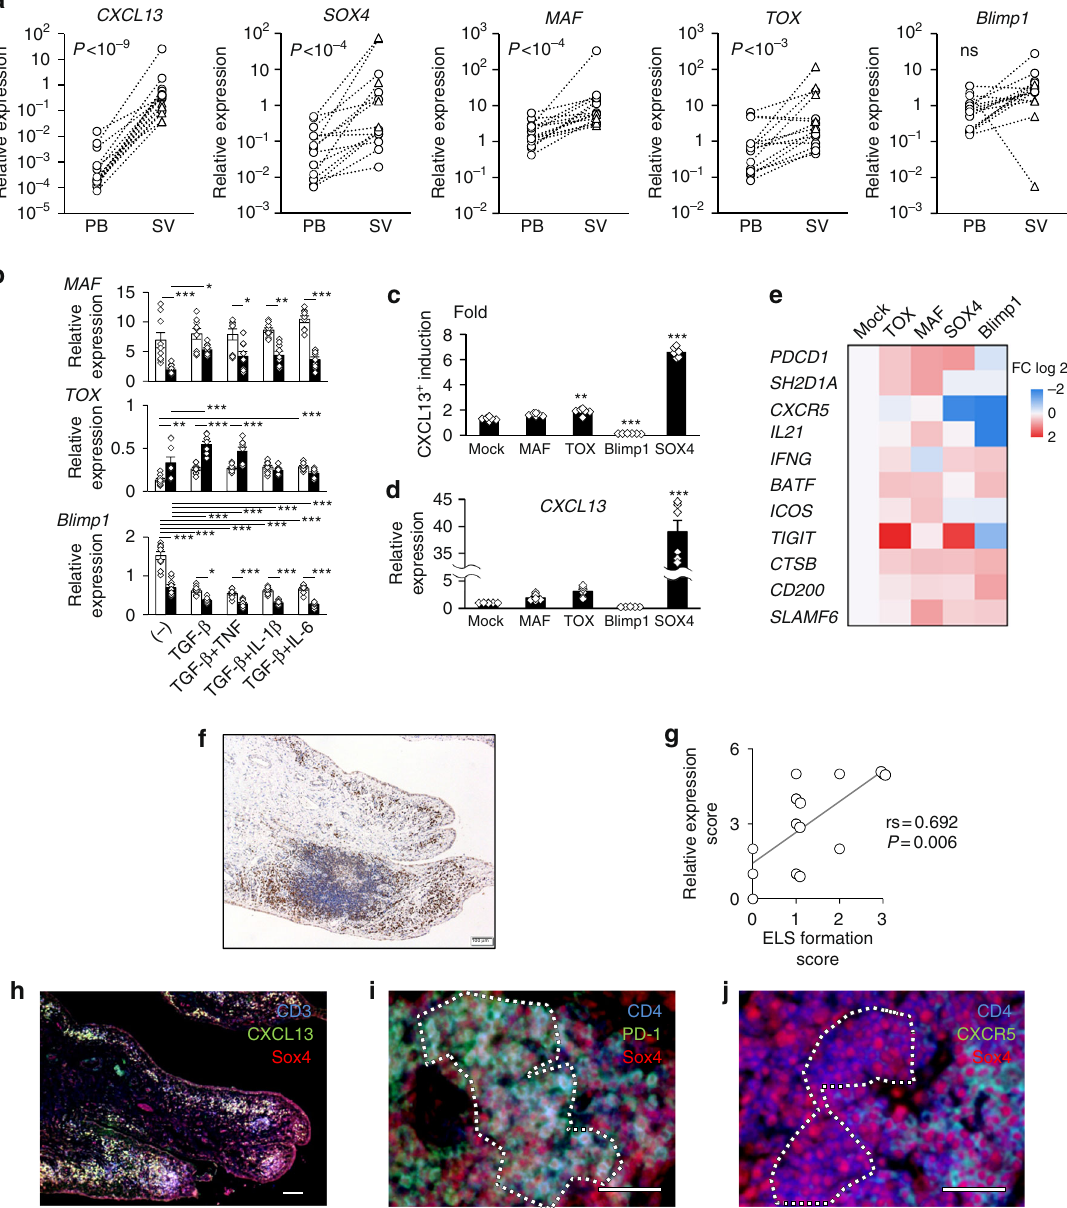
Fig. 5 Upregulated Sox4 expression in CD4 + T cells at local in fl ammatory sites correlates with ELS formation. a Relative expression of the indicated mRNA in paired peripheral blood (PB) and synovial (SV) CD4 + T cells (open circle: synovial fl uid, n = 10; open triangle: synovium, n = 5) of RA patients (total n = 15) with paired t -test P -values. b Expression of MAF , TOX , and Blimp1 in CD4 + T cells differentiated with the indicated cytokines in the presence (solid) or absence (open) of neutralizing anti-IL-2 antibody as in Fig. 2g. n = 9. c , d Human CD4 + T cells transduced with MAF, TOX, Blimp1, or Sox4 were differentiated for 5 days. Relative induction of CXCL13-positive cells in YFP + cells compared with YFP - cells ( c ) and relative CXCL13 expression in sorted YFP + cells ( d ) are shown. n = 6. e Heat map visualization of gene expressions assessed by quantitative PCR in sorted YFP + T cells transduced with the indicated transcription factor. Gene expression was normalized by that in mock-transduced cells in d and e . f , g RA synovial tissues were stained with Sox4 antibody (brown) and hematoxylin (blue). A representative image ( f ) and graphical summary of scores for ELS formation and Sox4 expression with P - and rs values of Spearman ’ s rank correlation ( g , n = 14) are shown. h – j Triple immunostaining of RA synovial tissues with the indicated antibodies. Hashed lines indicate representative PD-1 + CD4 + ( i ) and CXCR5 - CD4 + ( j ) populations. Scale bars: 100 μ m in h and 50 μ m in i , j . See Supplementary Figures 9 and 10 for detailed results. The data are presented as the mean ± SEM. * P < 0.05, ** P < 0.01, and *** P < 0.001 one-way ANOVA, Tukey ’ s test; ns, not signi fi